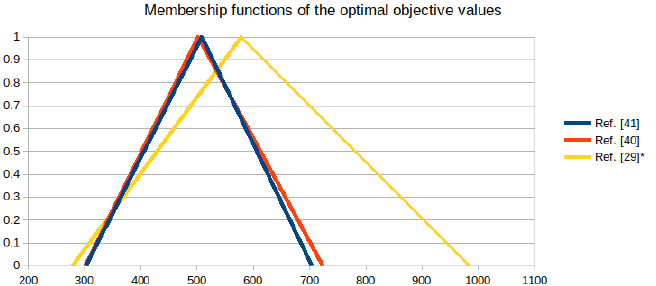
Figure 4. Graphic representation of optimal objective values reported in Table 2. Symbol ∗ marks the reference that introduced the approach that comply to the extension